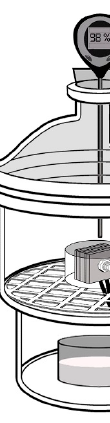
Figure 3. An illustrative diagram of ACM into the desiccator.